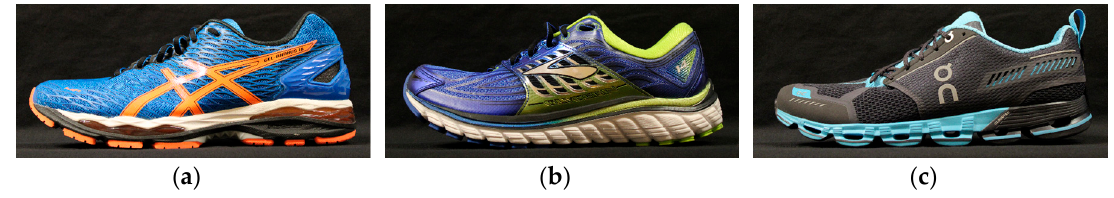
Figure 1. ( a ) Asics GEL-NIMBUS 18, ( b ) Brooks GLYCERIN 14, ( c ) On